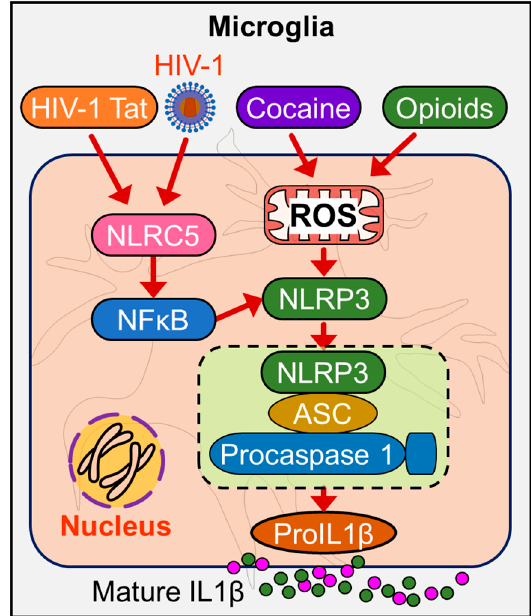
Figure 2. Schematic diagram depicts the mechanism(s) by which HIV-1 / HIV-1 Tat and drug abuse modulate the NLRP3 and NLRC5 inflammasome signaling in the microglial cells. HIV-1 / HIV-1 proteins, and drugs of abuse co-operatively activate microglia via: a) downregulated expression of NLRC5 resulting in activation of NF- κ B (signal 1), leading, in turn, to transcriptional upregulation of NLRP3, and IL1 β , and b) induction of ROS-mediated mitochondrial dysfunction (signal 2), which, in turn, induces assembly of NLRP3 inflammasome, leading to increased cleavage and secretion of mature IL1 β , ultimately culminating in neuroinflammation and ensuing inflammaging.